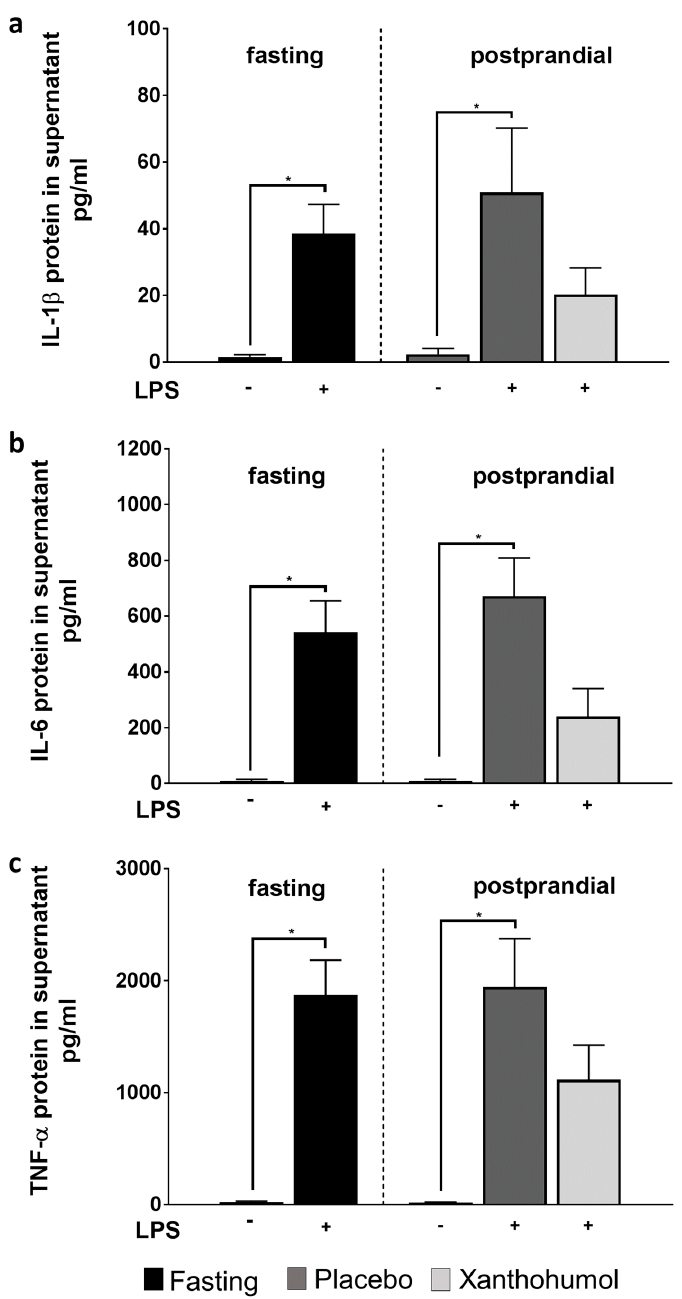
Figure 3. Cytokine concentrations in supernatant of LPS − stimulated PBMCs obtained from healthy study participants. Protein concentrations of IL −− 1 β ( a ), IL −− 6 ( b ) and TNF −−α ( c ) in cell culture supernatant of PBMCs stimulated with 0 or 100 ng/mL LPS for 2 h isolated from healthy study participants receiving either a placebo or the study drink containing XN derived through a XN − rich hop extract. IL, interleukin; LPS, lipopolysaccharide; PBMC, peripheral blood mononuclear cell; XN, xanthohumol. Data are expressed as means ± SEM. * = p < 0.005.